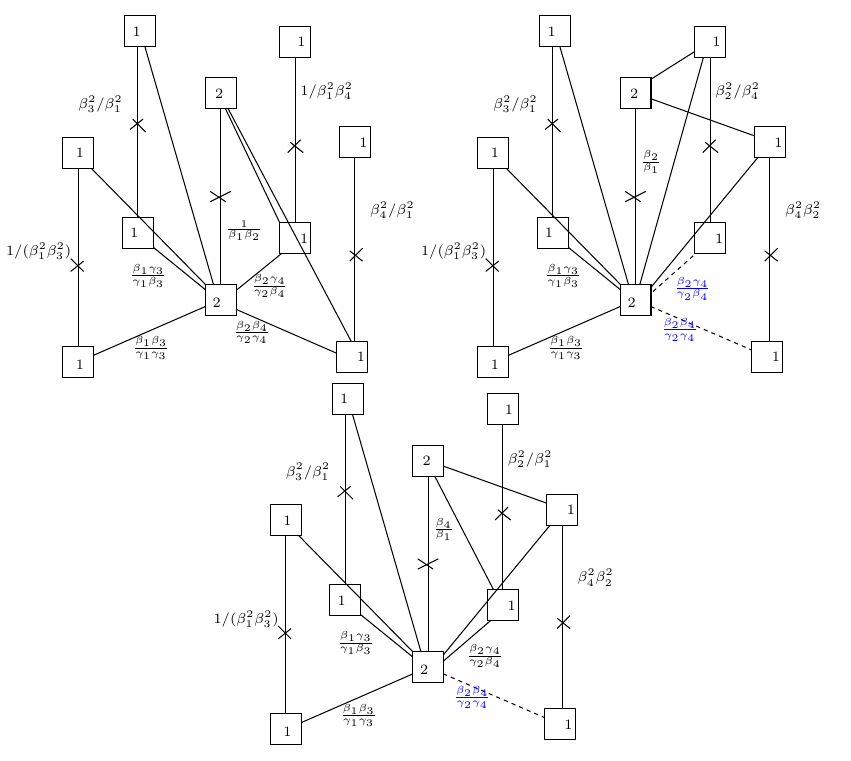
Figure 27 . Three di(cid:11)erent tubes for the D 4 case. The two punctures are of opposite sign and di(cid:11)erent colors. The dotted line represents the M i which in the cases the line appears are composites. The groups labeled by 1 are SU( N ) and groups labeled by 2 are SU(2 N